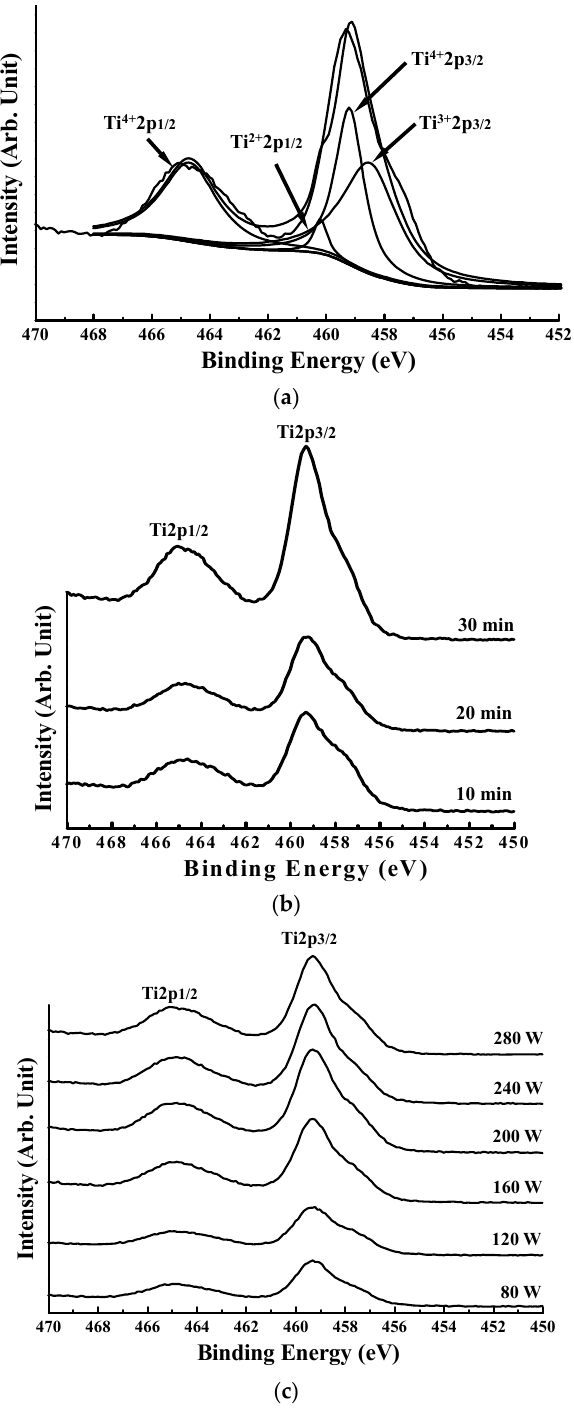
Figure 2. ( a ) Typical high ‐ resolution X ‐ ray photoemission spectroscopy (XPS) spectrum of Ti 2p from the plasma ‐ oxidized sample at 80 W for 10 min, ( b ) XPS spectrum of Ti 2p from the plasma ‐ oxidized sample at 80 W for various durations and ( c ) XPS spectrum of Ti 2p from the plasma ‐ oxidized samples at different powers for 10 min.